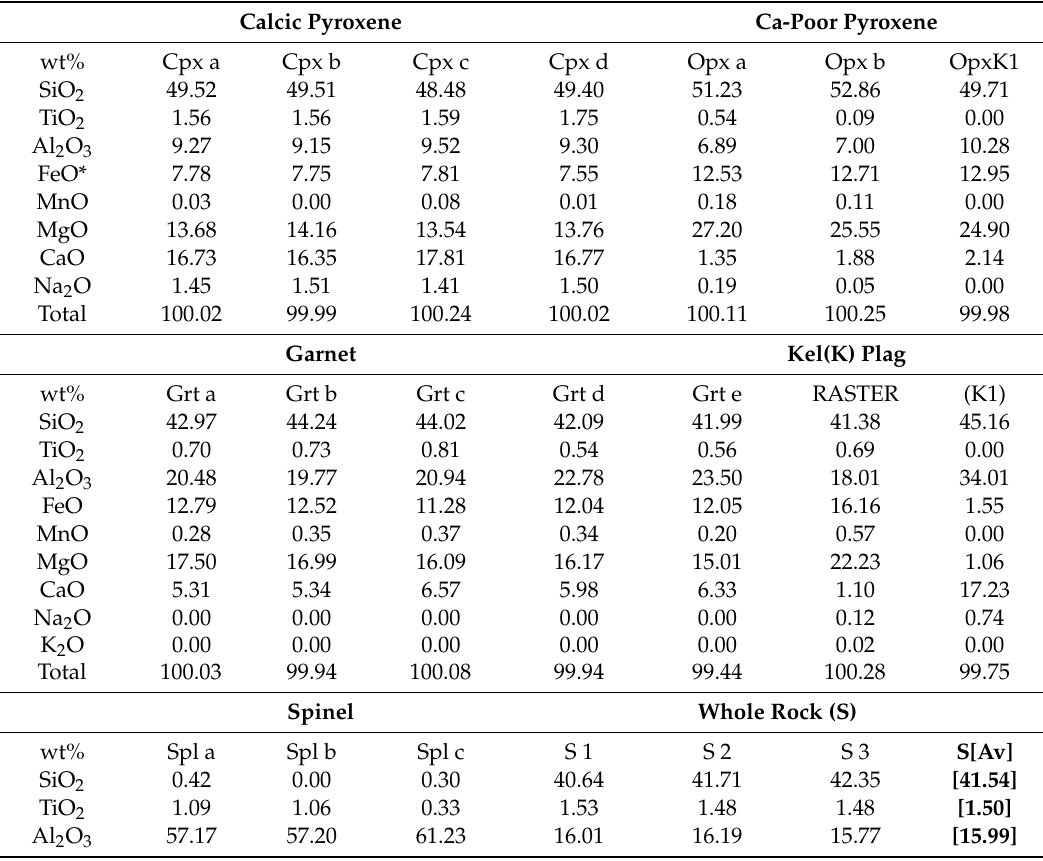
Table 1. Major element abundances of the whole rock samples (S1, S2, S3), theirs average values (S) and the constituent minerals (Calcic pyroxene: Cpx, Ca-poor pyroxene: Opx, garnet: Grt and Al-spinel: Spl). Composition of a square area (Raster), with 75 mm long side, of the fine grained kelyphite (K) and spot analyses on the Ca-poor pyroxene and plagioclase (Plag) in the coarse kelyphite (K1), are also